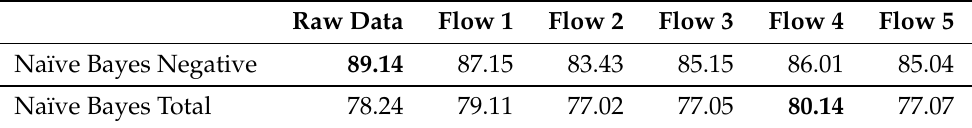
Table 7. Accuracy of the naïve Bayes negative and total classifiers after cross validation with the entire